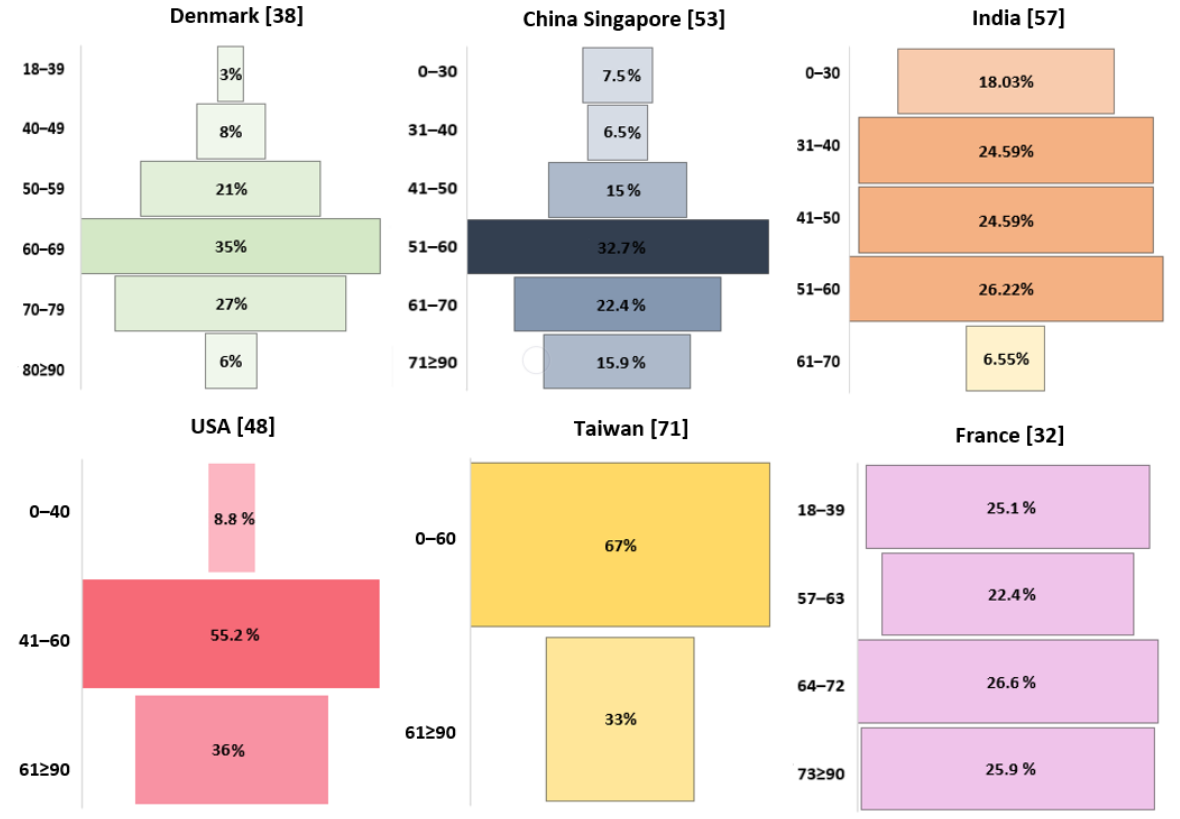
Figure 3. Age-related incidence of GBM.